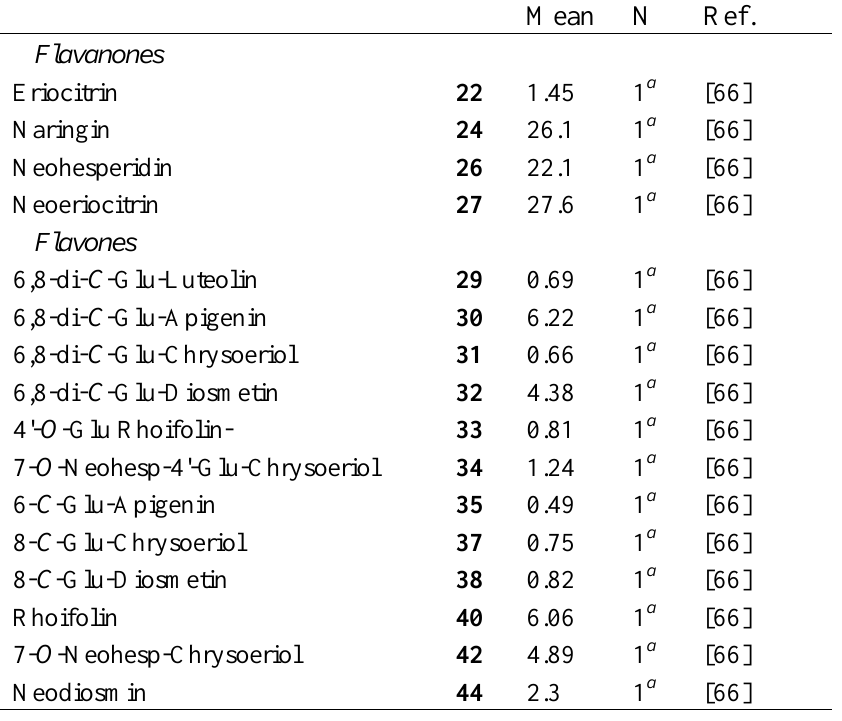
Table 16 . Flavonoid composition of commercial bergamot juice (mg/100